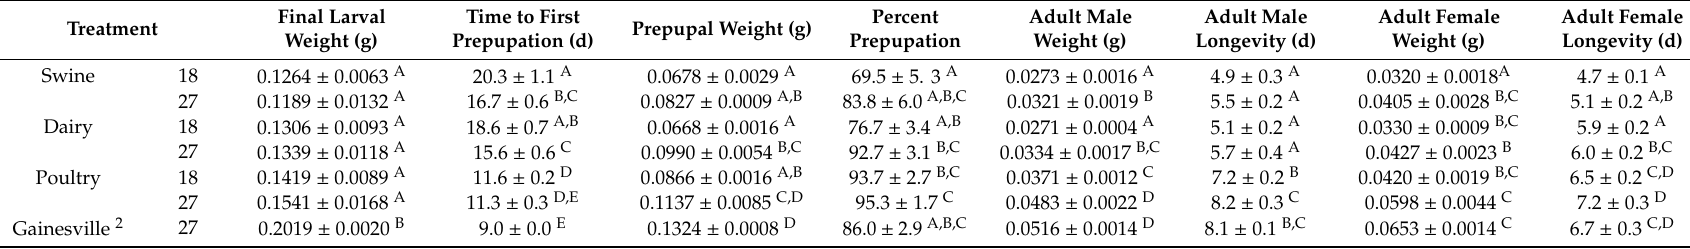
Table 3. Comparison of life-history traits (mean ± SE, 1 n = 6) of black soldier fly larvae fed swine, dairy, or poultry manure at two feed rates or Gainesville diet [32] every other day at 29 ◦ C, 60% RH, and